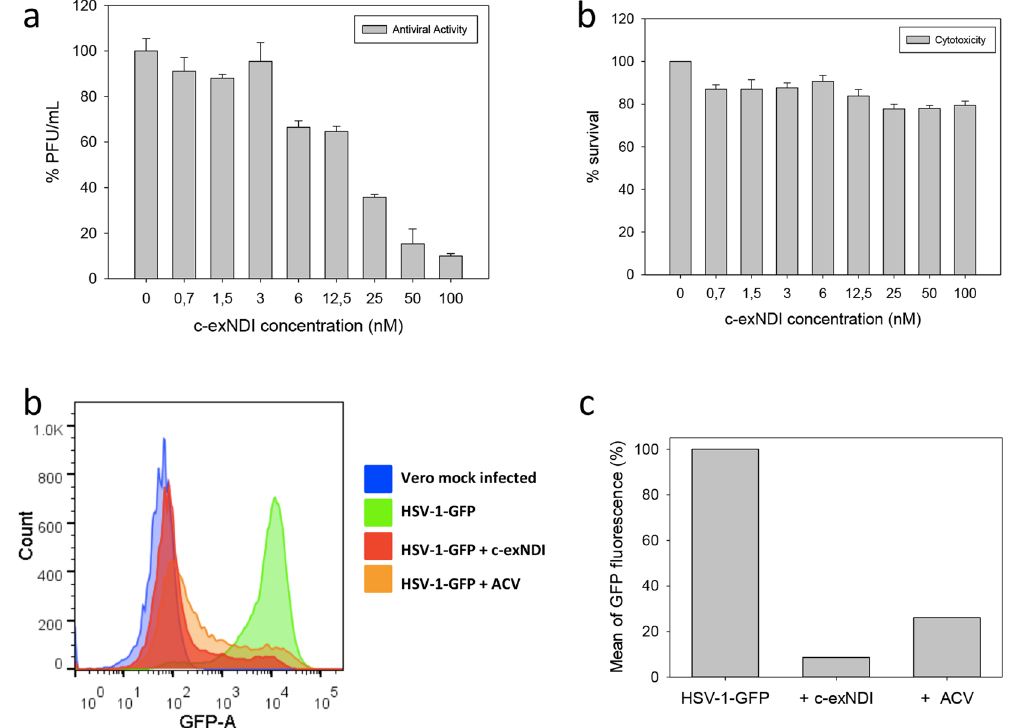
Figure 3. Anti-HSV-1 activity of c-exNDI. ( a ) Plaque assay: Vero cells were infected with HSV-1 strain F (MOI 1, as previously reported 27 ) and treated with increasing concentrations of c-exNDI (0.7 nM–100 nM). Supernatants were collected 24 h.p.i. and the number of plaque forming units was determined. ( b ) Vero cells were treated at the same concentrations of c-exNDI (0.7 nM–100 nM) used in the antiviral assay and cytotoxicity was evaluated by MTT assay. ( c ) Flow cytometry of HSV-1 [V41]-infected cells treated with c-exNDI and ACV. HSV-1 [V41]-infected cells were used as positive control and their GFP fluorescence set to 100%. C-exNDI (red curve) and ACV (orange curve)-treated infected cells were compared to HSV-1 [V41]- infected cells (green curve) to monitor compound inhibition of GFP fluorescence. ( d ) Quantification of the mean of GFP fluorescence upon treatment of HSV-1 [V41]-infected cells with c-exNDI and ACV, observed in ( b ).